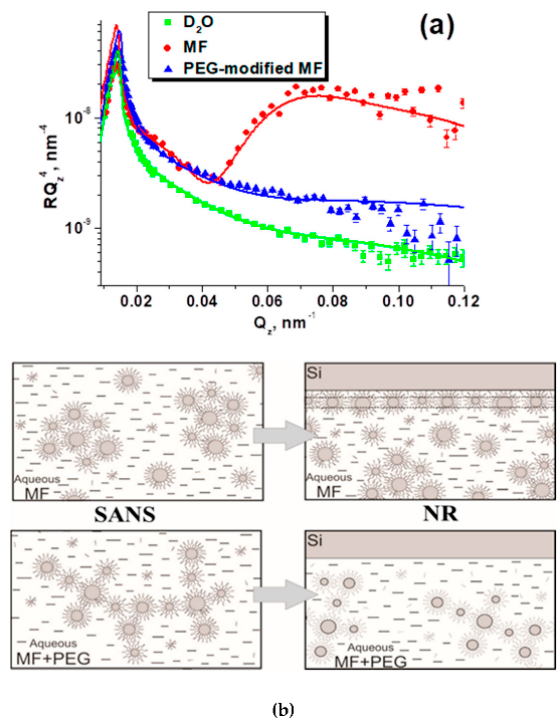
Figure 15. ( a ) Neutron reflectometry data for initial aqueous ferrofluids, PEG-modified ferrofluids and just buffer (D2O) at interface with solid (Si). It could be seen that reflectivity curves for PEG-modified ferrofluids and just carrier (D2O) are very similar and indicates on the absence of any nanoscale layer at interface. ( b ) Correlation between bulk structure of ferrofluids according to SANS and at interface ferrofluids/solid according to neutron reflectometry investigations. It is shown that there is no any adsorption of MNPs on solid in case of fractal branched aggregates in ferrofluids bulk. Reprinted with permission from Reference [153].